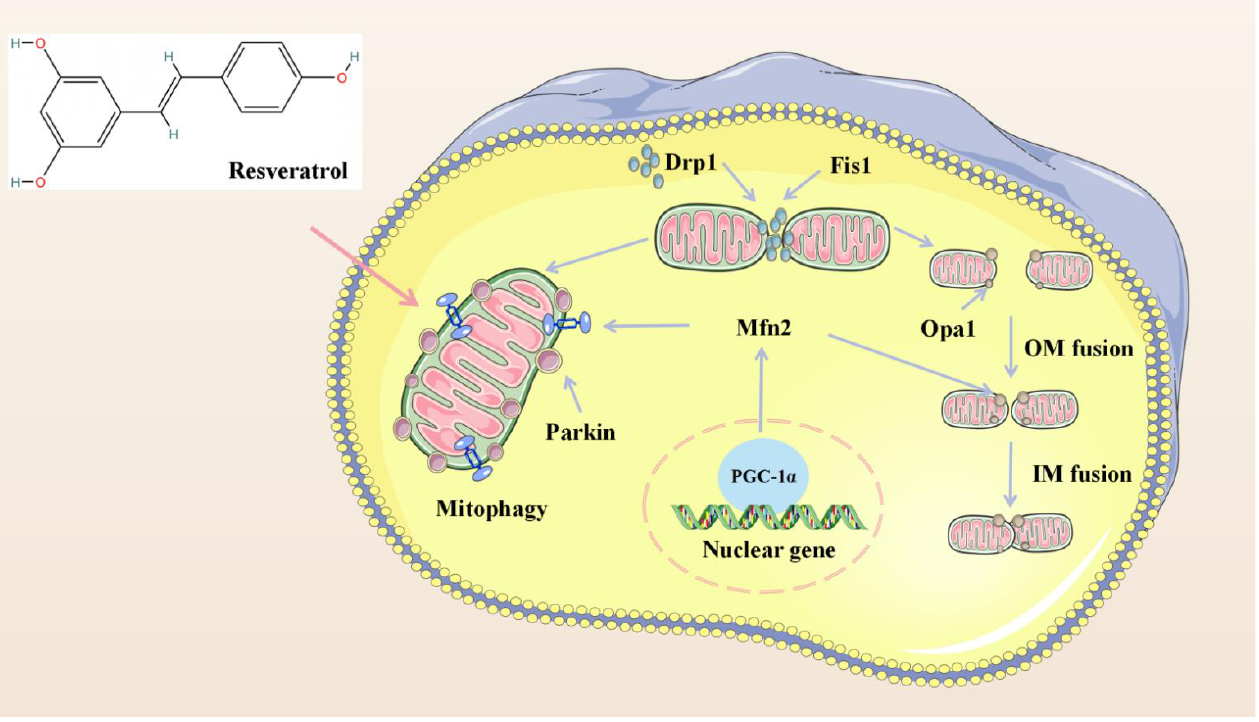
Figure 5. Overview of proposed mechanism of resveratrol reestablishes mitochondrial quality control in myocardial ischemia/reperfusion injury through the Sirt1/Sirt3-Mfn2-Parkin-PGC-1α pathway.